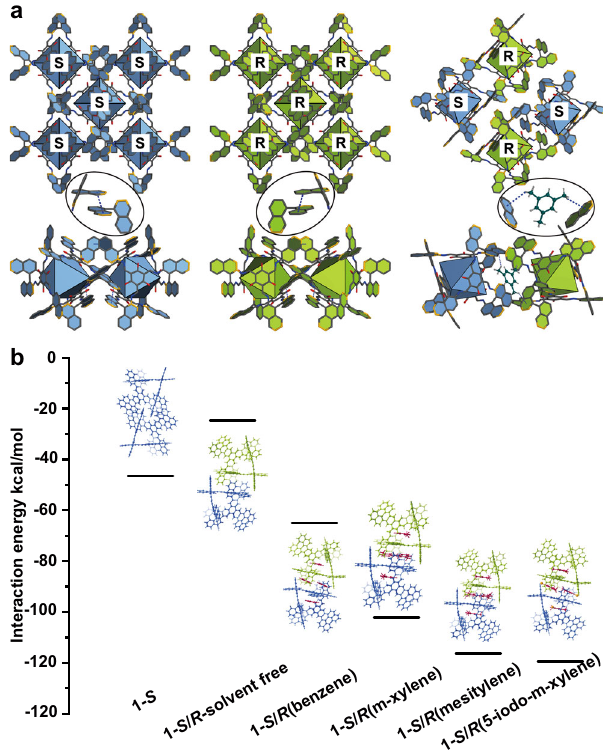
Fig. 3 The structures of the cage-cage assembly and interaction energies analysis by DFT calculations. a Schematic representation of the interaction between cages and also between solvent molecules and cages in homochiral and heterochiral structures. b The interaction energies calculated at PBE0-D3/6-31 G(d,p) level for staking structures.